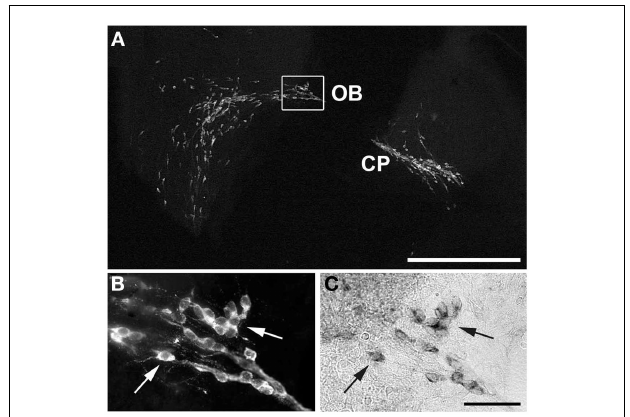
FIGURE 2 | Co-localization of GnRH and Kiss1r in migrating neurons . Kiss1r and GnRH were co-localized in migrating GnRH neurons in E15 mice. (A) shows a digital image of a fluorescent IHC for GnRH in a sagittal section from an E15 female also positive for Kiss1r . (B) (GnRH) and (C) ( Kiss1r ) show higher magnification images of the boxed area in (A) , with arrows to indicate co-expressing cells. Compare the GnRH pattern in A to the Kiss1r pattern seen in the bottom right corner of Figure 1 . CP, cribriform plate; OB, olfactory bulb. Scale Bars: white = 500 µ m, black = 100 µ m.